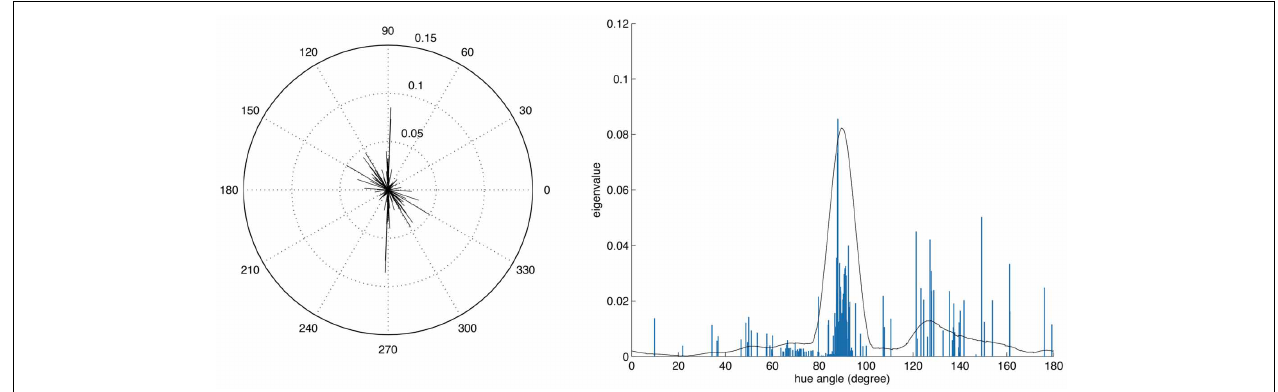
FIGURE 7 | Distributions of opponency directions in color space. Each line in the polar and linear plot indicates the direction of the opponency axis for a single ATA or basis function. The lengths of the lines indicate the spread